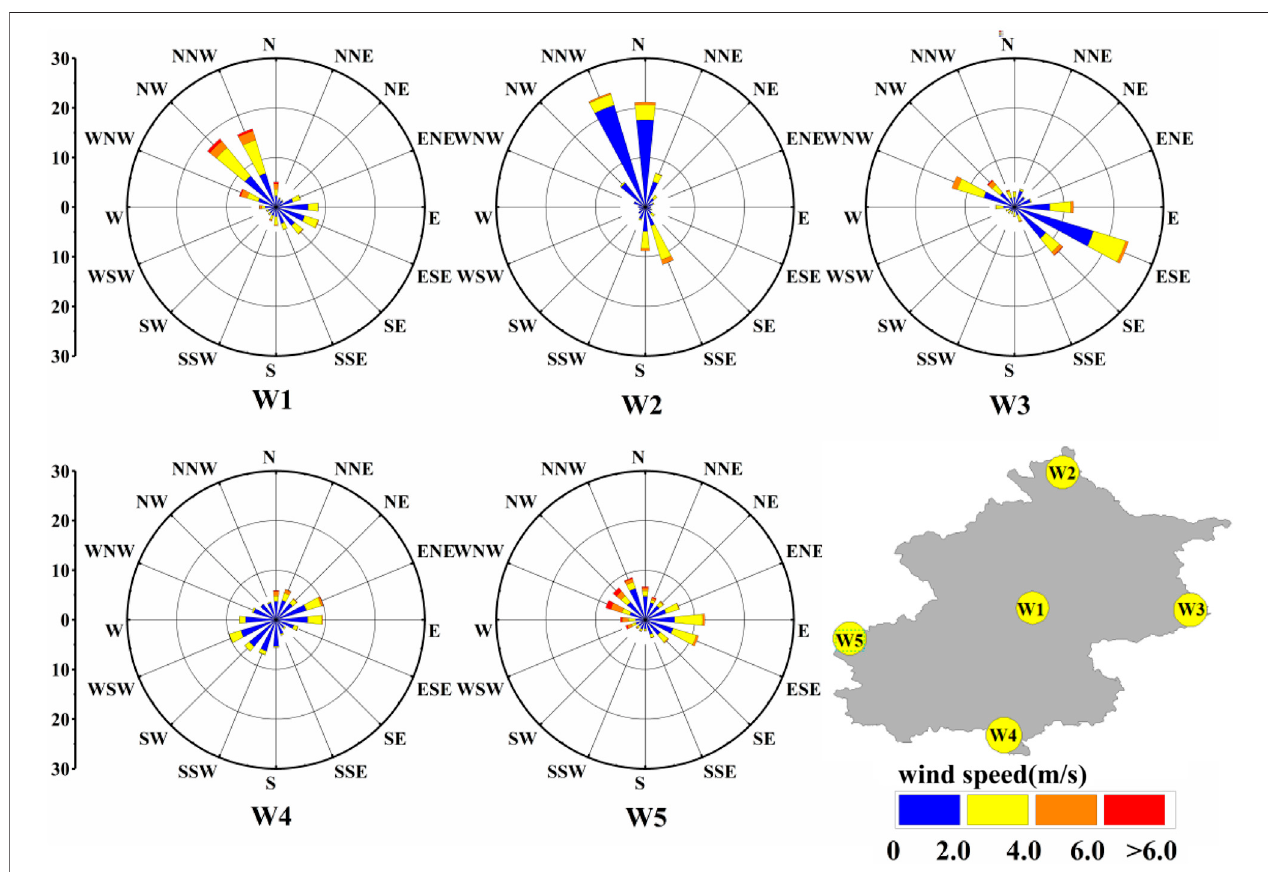
FIGURE 4 | Wind rose showing direction and speed of 5 weather stations in